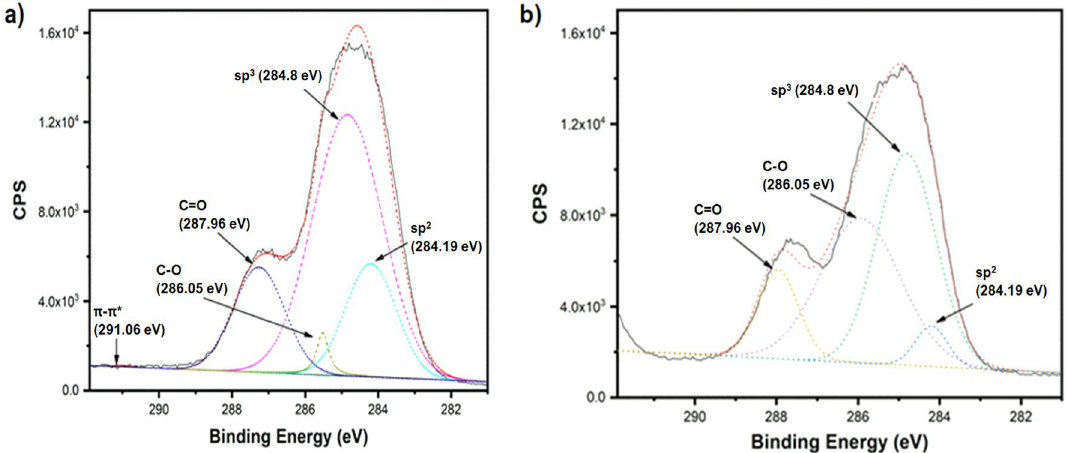
Figure 5. C1s XPS spectra of C-dots prior ( a ) and after ( b ) chronoamperometry treatment at 2.0 V for 60 s. Solid lines refer to the recorded data, while the dashed lines refer to the fitted curves.